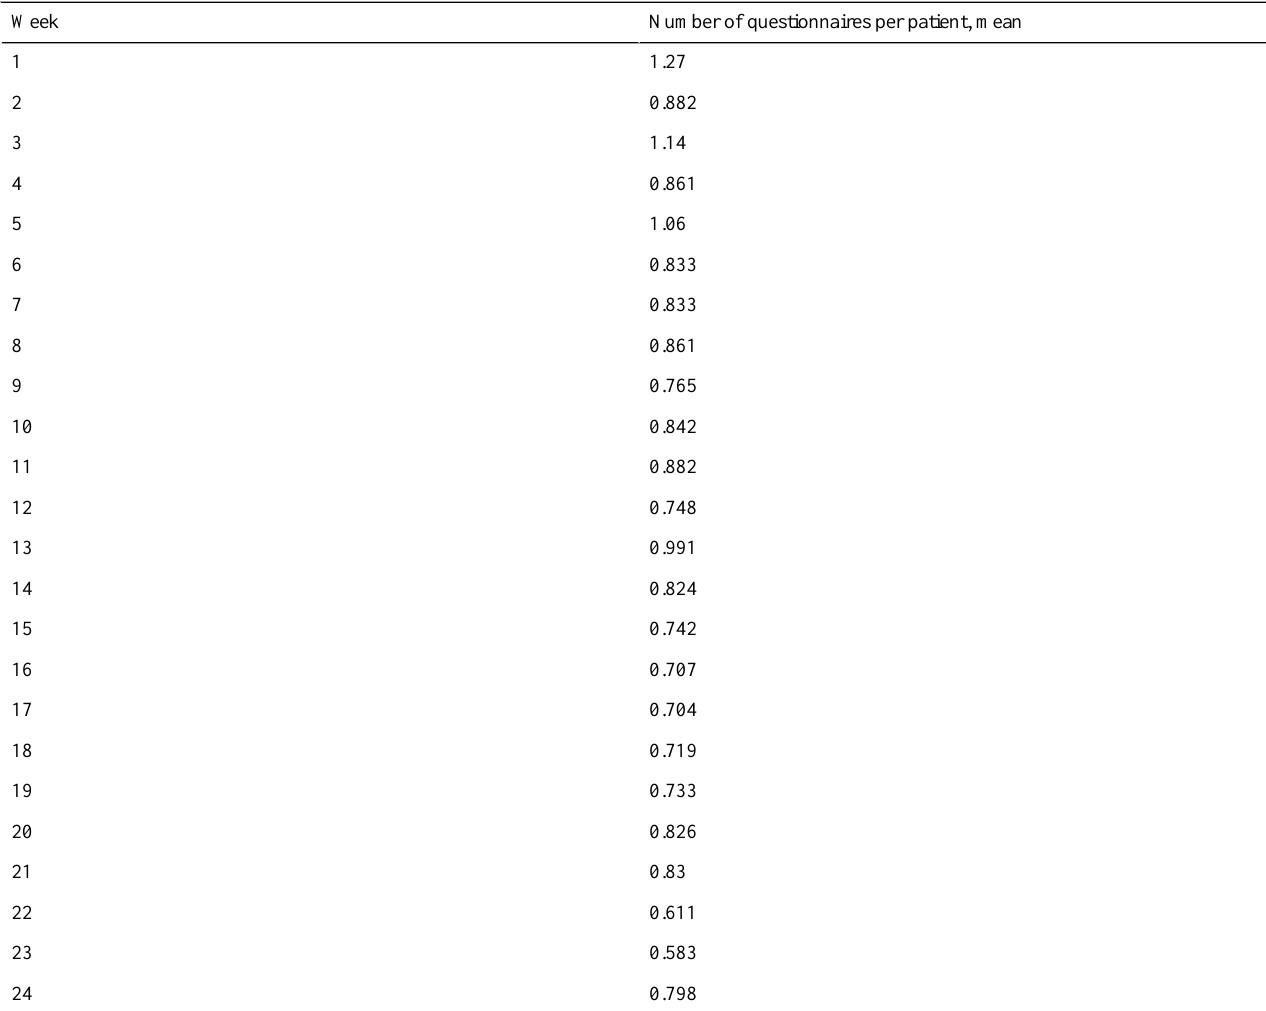
Table 2. Average number of answered symptom questionnaires completed per patient per week, up to 24 weeks. Number of questionnaires per patient,